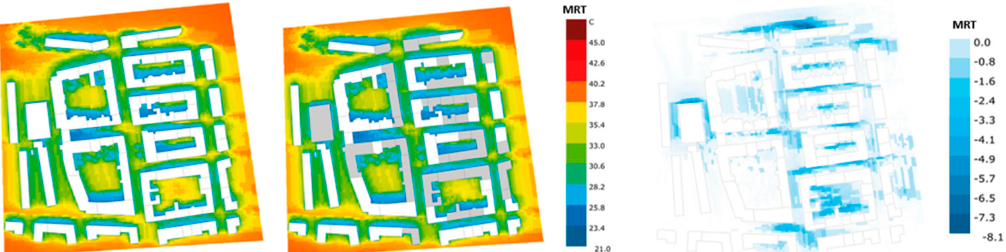
Figure 8. Twenty-four-hour MRT at street level for smaller sample area for base case ( left ) and densification scenario ( middle ) and 24-h MRT differences at street level between base case and densification scenario.